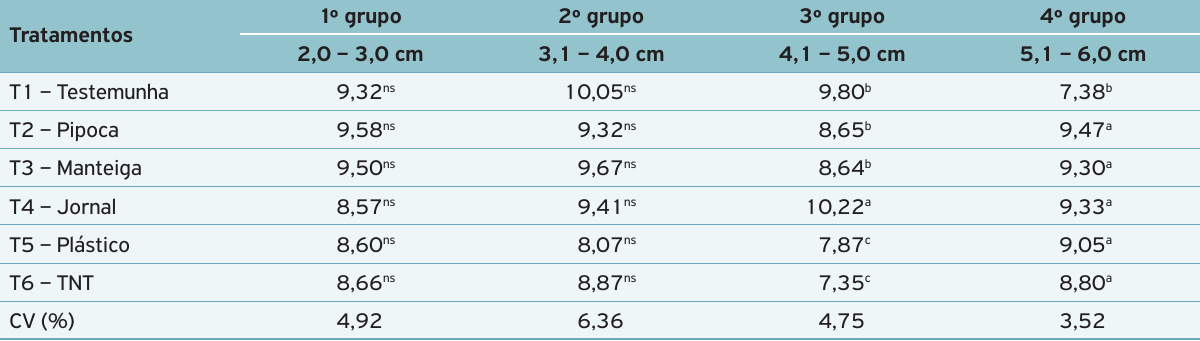
Tabela 5. Valores médios de sólidos solúveis totais (ºBrix) obtidos em quatro grupos de diâmetros de goiabas ensacadas